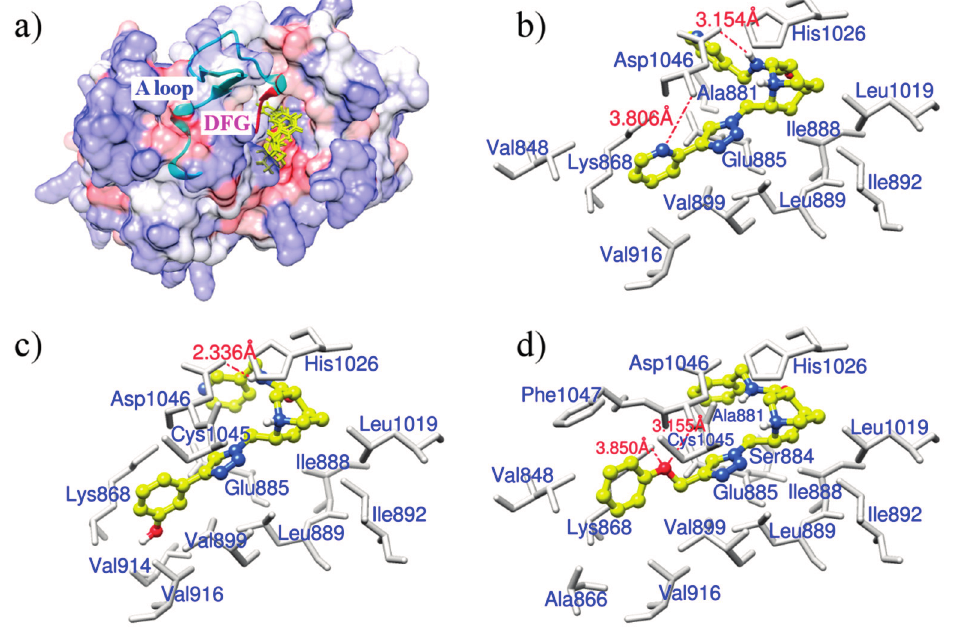
Figure 2. ( a ) An overview of binding modes for the three derivatives in the binding pocket of VEGFR-2. Derivatives are shown as yellow sticks. The surface of VEGFR-2 is colored to show hydrophobicity: from dodger blue for the most hydrophilic, to white, to orange red for the most hydrophobic. The activation loop (A loop) of VEGFR-2 is displayed as cartoon in cyan and the DFG motif of the activation loop is colored in red; ( b ) Binding mode for ZINC08254217; ( c ) Binding mode for ZINC08254138; ( d ) Binding mode for ZINC03838680. In ( b – d ), sticks in light gray are related residues of VEGFR-2, hydrogen bonds labeled with distance are shown as orange dashed lines, and derivatives are in shapes of ball and stick. Color codes for atoms of derivatives in ( b – d ): C is yellow, N is blue, and H is light